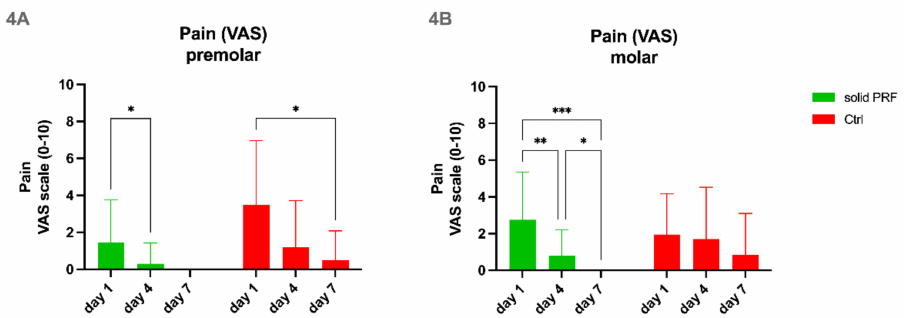
Figure 4. Pain perception (VAS). Pain perception was evaluated via visual analogue scale (VAS 0–10) in premolars ( 4A ), and molars ( 4B ) up to 7–10 days post tooth extraction. A continuous decrease in pain was observed for both solid PRF-treatment and control groups in both premolars and molars. A statistically significant reduction of pain from day 1 to day 4 could be observed in patients of solid PRF treatment groups for both premolars and molars. No statistically significant difference could be observed between the control and treatment group for either time point. Data are represented as mean ± SD. Significance levels are as follows: “*” p < 0.05; “**” p < 0.01; “***” p <